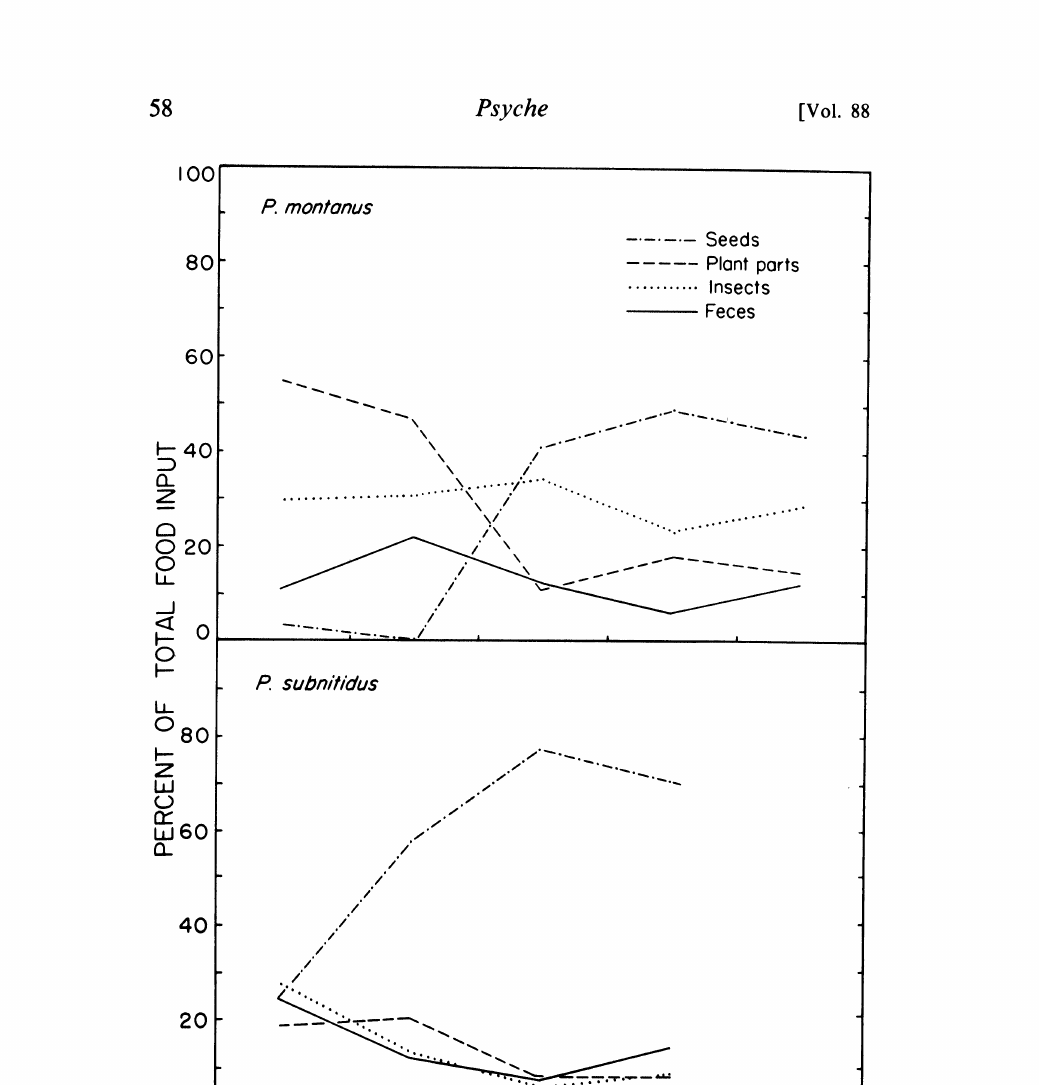
Figure 13. The seasonal changes in the food sources of P. montanus and P.